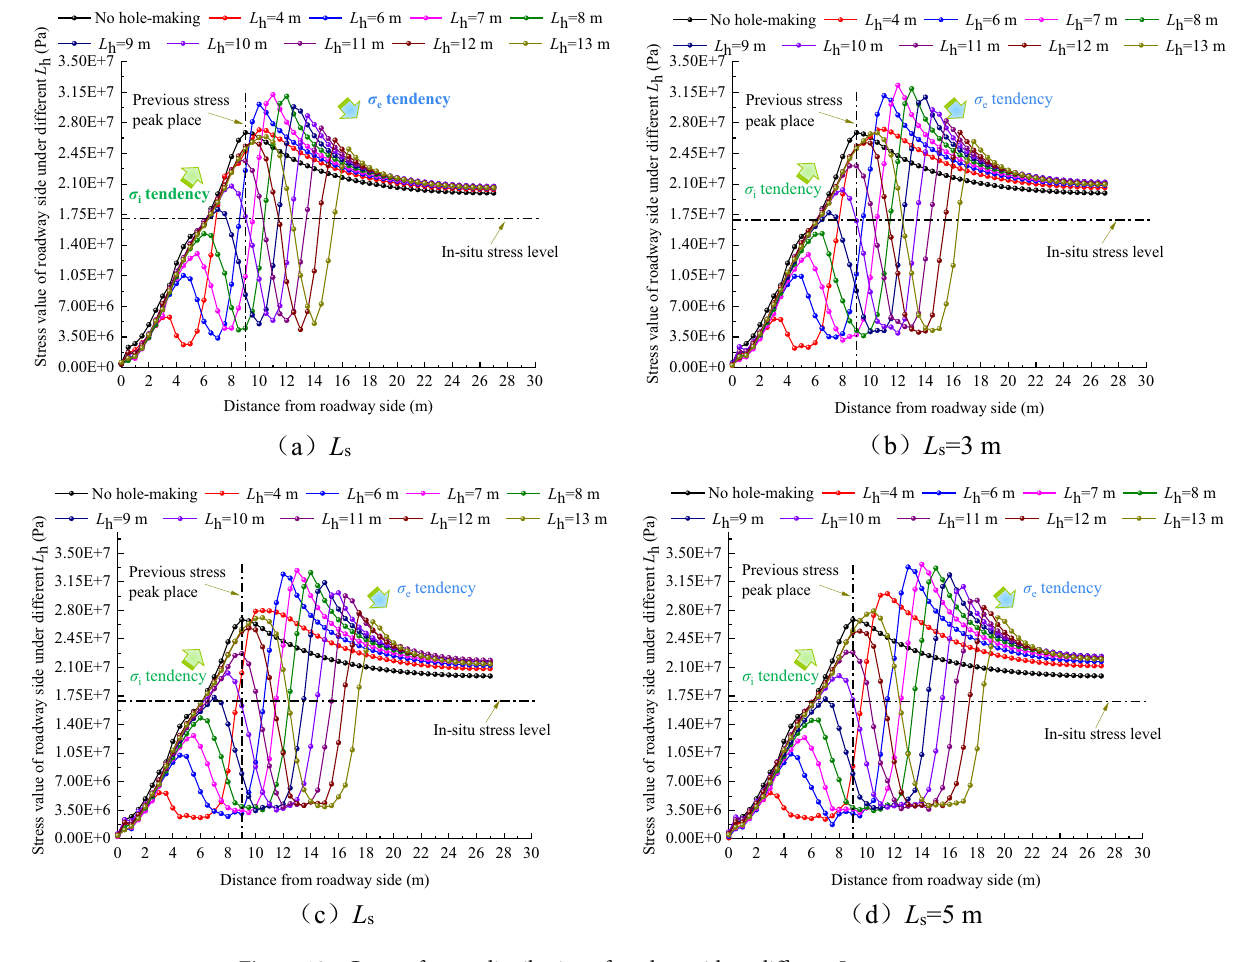
Figure 10. Curve of stress distribution of roadway side at different L